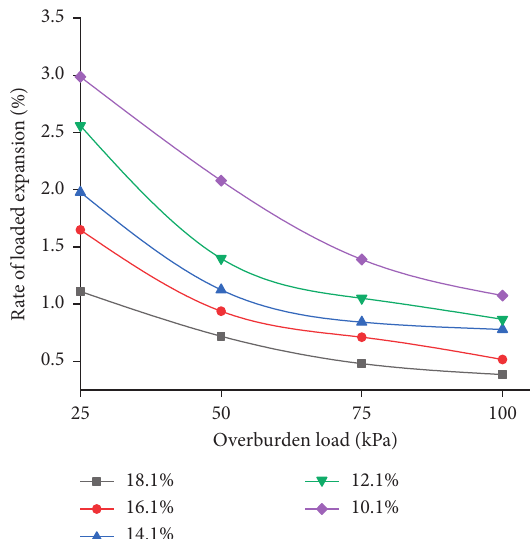
Figure 12: Time variation curve of the unloaded expansion rate of undisturbed soil.